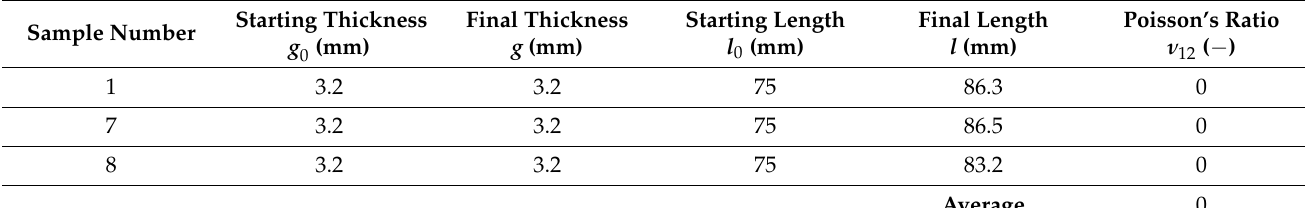
Table 7. Results collected from tensile strength tests.